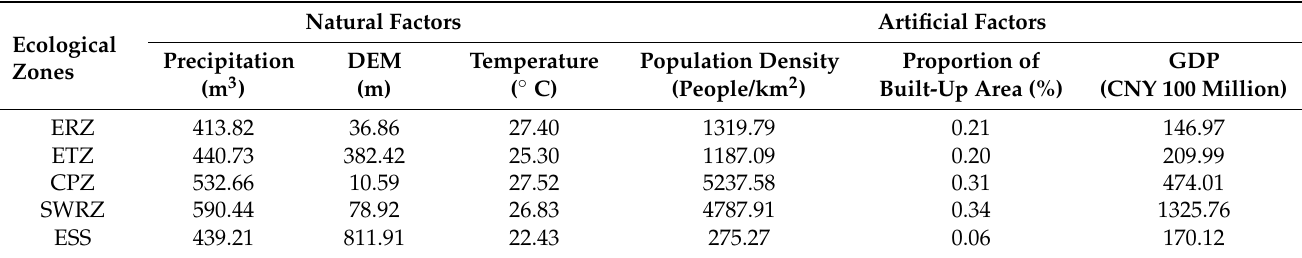
Table 4. Mean statistics of natural and artificial factors in different zones.